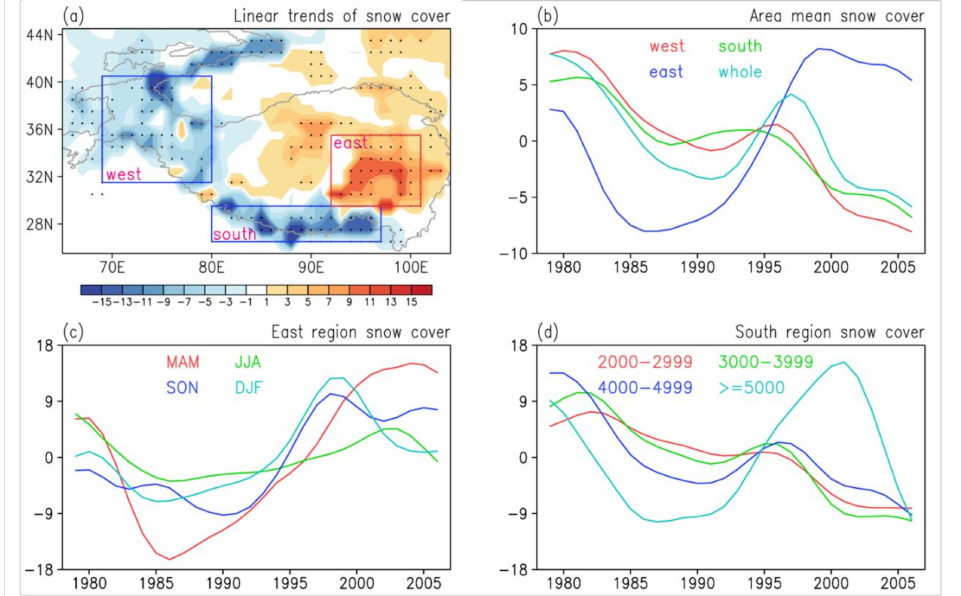
Figure 2. ( a ) Linear trends of annual mean snow cover (% decade − 1 ) for the period 1979–2006. Dotted regions denote trends significant at the 95% confidence level. The three boxes denote the domains of the west region, the south region, and the east region in calculating area-mean values. ( b ) Area–mean annual mean snow cover (%) anomalies in different regions. ( c ) Area–mean snow cover anomalies (%) in the east region in different seasons. ( d ) Area–mean annual mean snow cover anomalies (%) in the south region averaged for grid points with different elevations. The area–mean values are calculated by averaging values at grid points with elevation above 2000 m. The anomalies are calculated based on climatology for the period 1979–2006. All lines are ob- tained by a nine-year Gaussian filter. The analysis is based on the NSIDC snow cover data [27] (https://nsidc.org/data/NSIDC-0046/versions/4 (accessed on 3 May 2022)). (Based on modification of